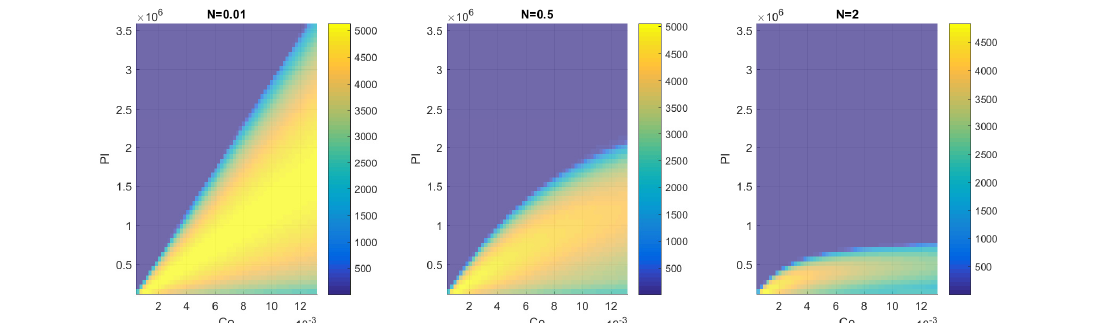
Figure 10. Average value of the pressure rise oscillations as a function of Co and Pl for different values of N for TOA = 4.24.